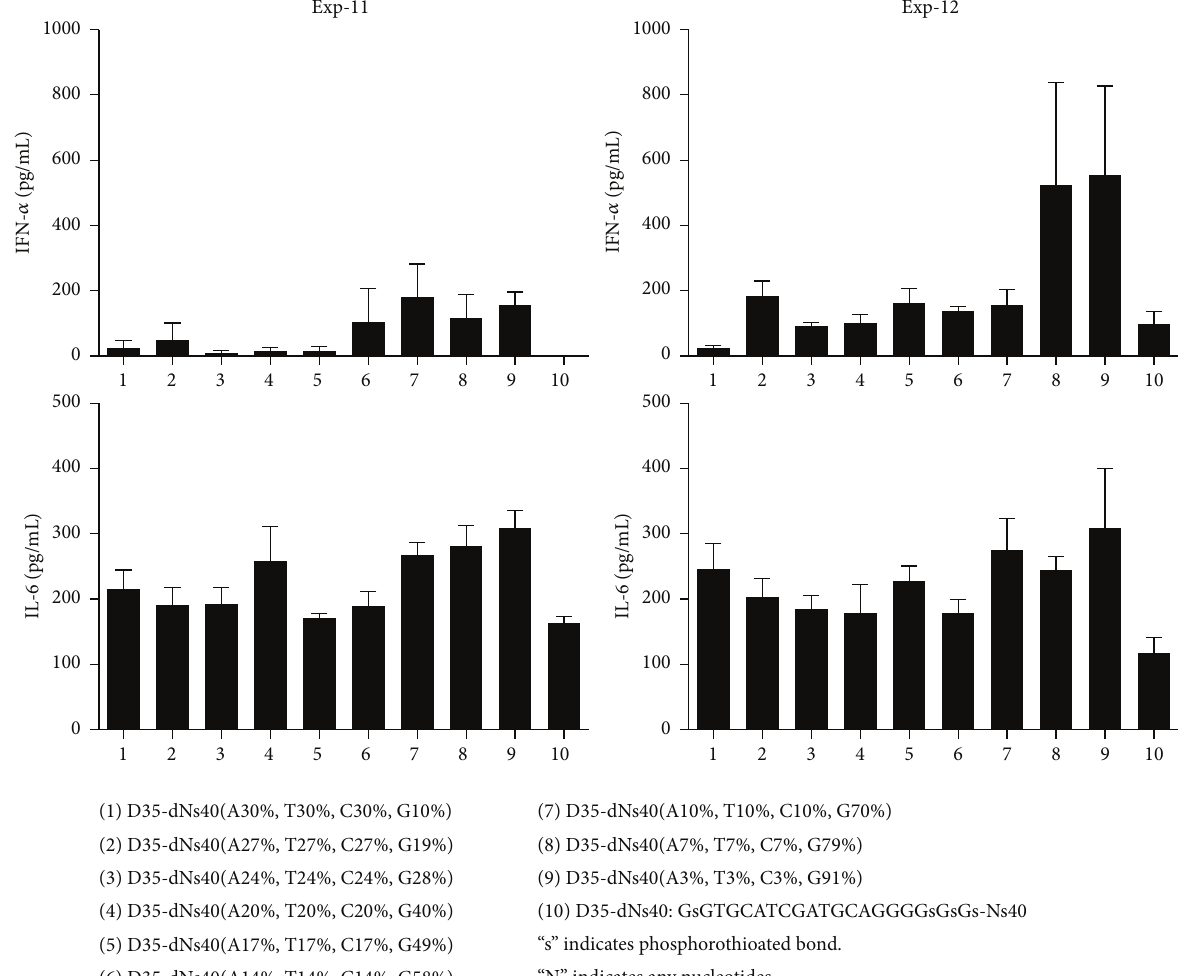
Figure 7: Nucleotide composition of the tail affects ODN’s immunostimulatory activities. Human PBMCs were stimulated with the indicated synthetic ODNs (1 𝜇 M) for 24 hours. IFN- 𝛼 and IL-6 production in the supernatants were examined by ELISA. Of note, D35-dNs40 (number 10) did not induce substantial IFN- 𝛼